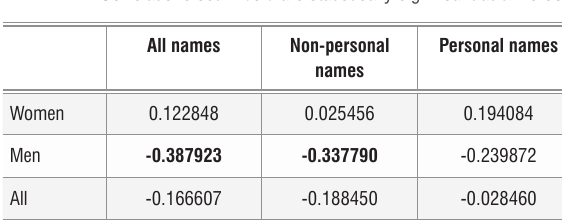
Pearson’s correlation coefficients for the relationship between respondents’ ages and the numbers of names they reported. Correlations set in bold are statistically significant at α =0.05.